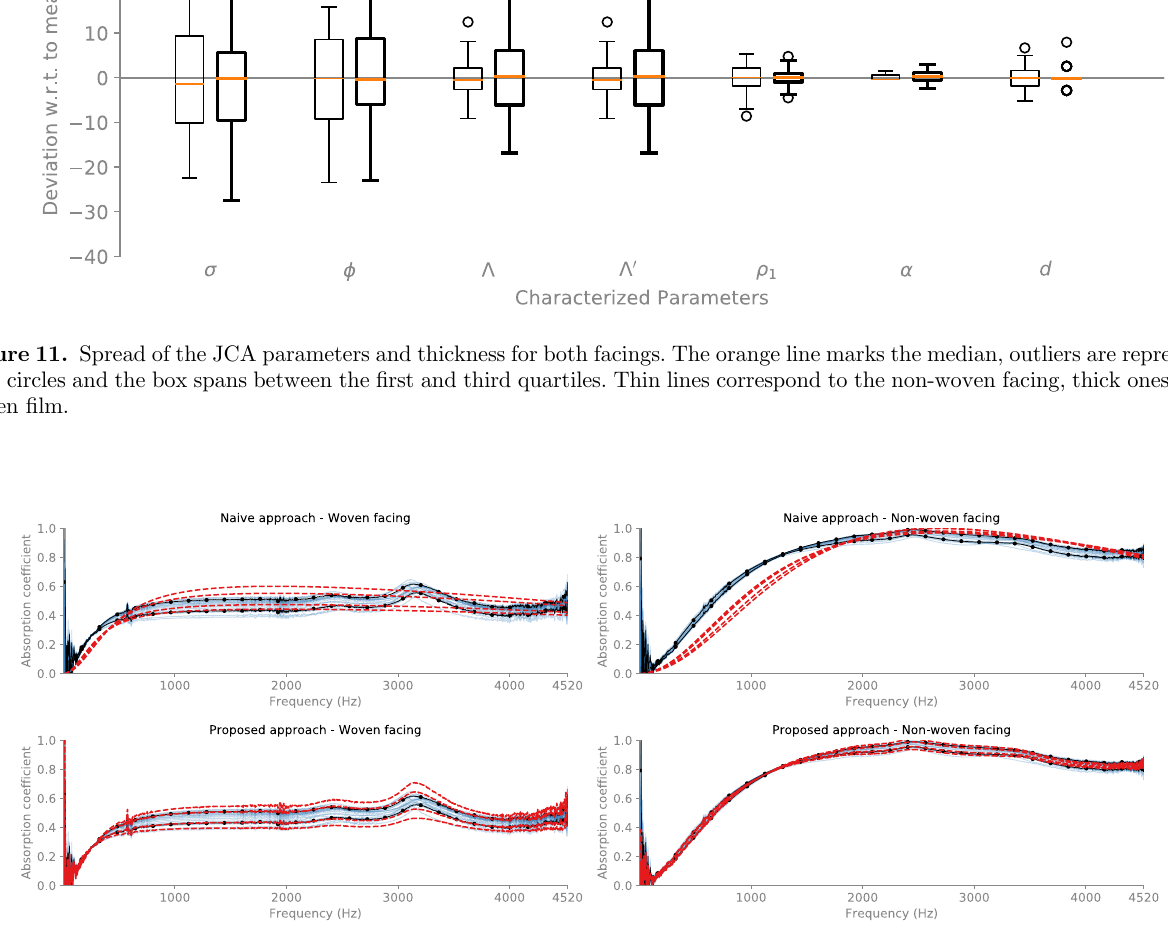
Figure 12. Case of a melamine backing. Comparison of envelopes (in red) annotated on the mean response as proposed in Section 2.3 (bottom) and envelopes generated using the JCA characterisation of the backing and the fi lm (top). For a woven fi lm (left) and a non- woven (right). The blue light traces are sample responses and the black curve with bullets (cid:7) is the standard deviation